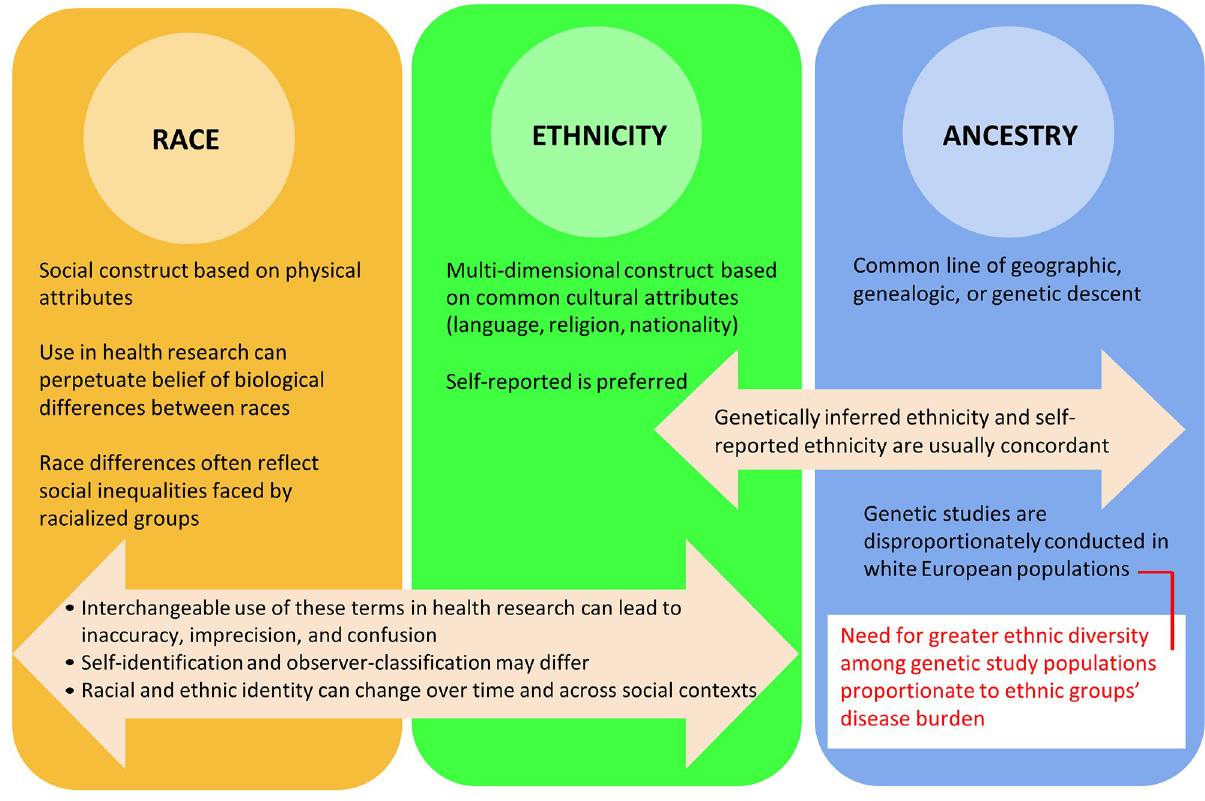
Fig 3. Race, ethnicity, and ancestry considerations in health research.